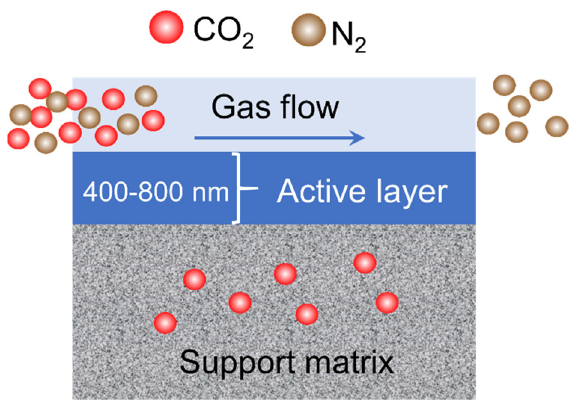
Figure 14 . Mechanism of CO 2 /N 2 separation using PVA/CNC as active layer . Figure 14. Mechanism of CO 2 /N 2 separation using PVA/CNC as active